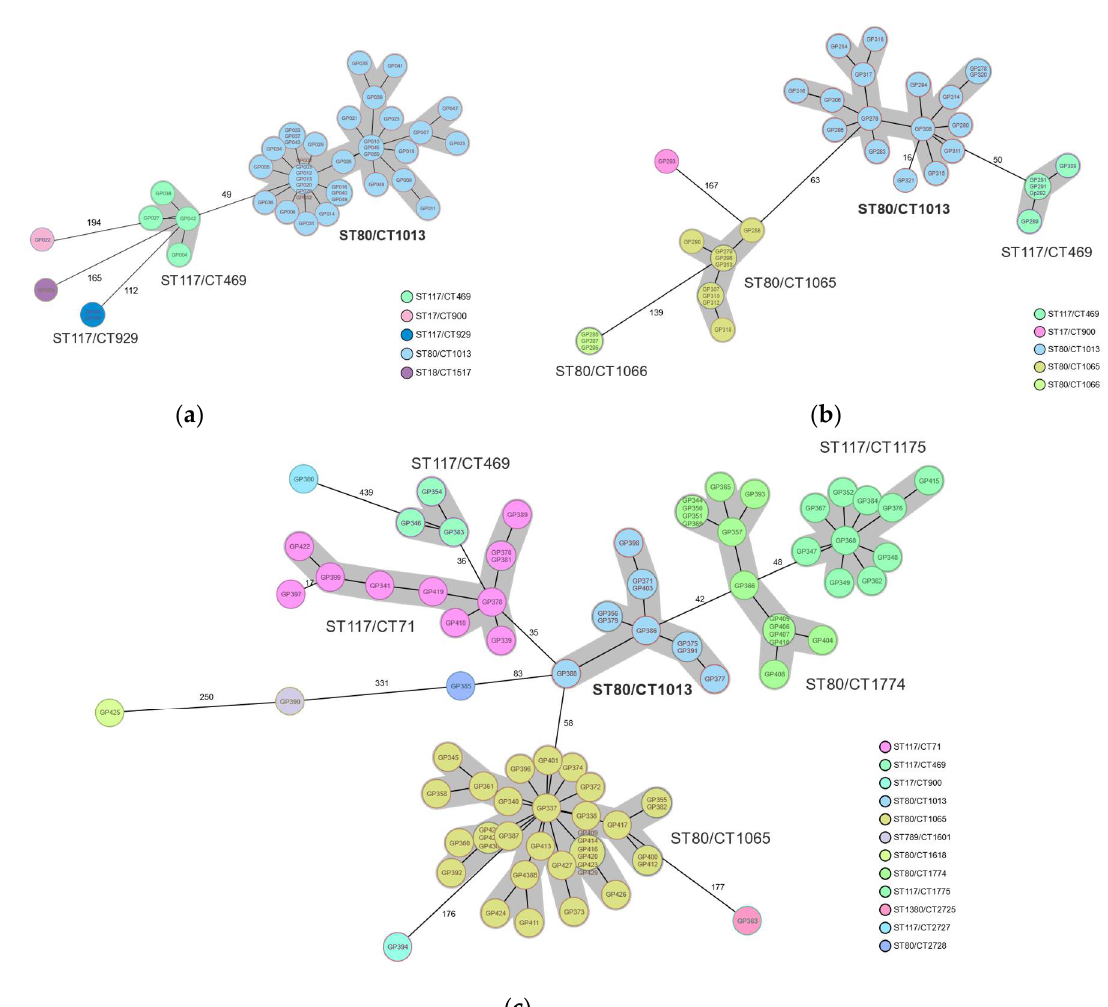
Figure 2. Genotyping results of VRE isolates from a nosocomial outbreak in two interconnected hos- pitals in Southern Germany, October 2015–November 2019. ( a ) Core genome multi-locus sequencing typing at the beginning of the outbreak 2015–2016. The large cluster of ST80/CT1013 is highlighted in blue. ( b ) Genotype distribution of isolates obtained from a point prevalence study in May 2017. ( c ) Genotypic assessment of isolates obtained between December 2018 and March 2019. Color-coding according to complex types (CT) based on the cgMLST nomenclature. Sequence types (ST) and CTs are shown adjacent to the clusters, highlighted in grey, which represent closely related isolates (difference ≤ 15 alleles). Numbers adjacent to connecting lines represent allelic differences between isolates with variation in more than 15